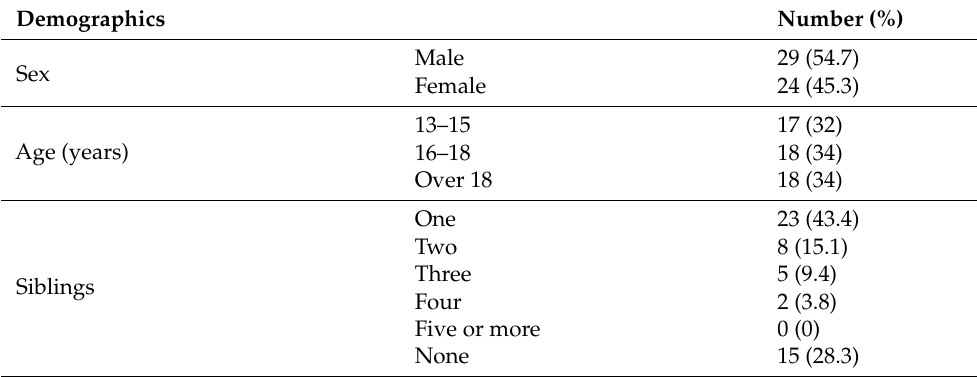
Table 2. Demographic information of the adolescents with disability ( n =